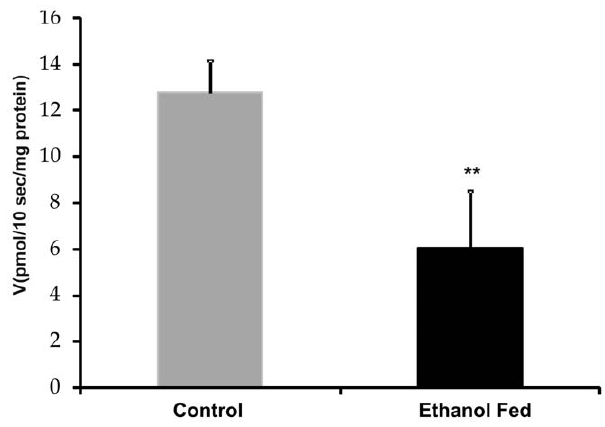
Figure 3. Uptake of 5-[ 14 C]-methylTHF (0.5 m M) was measured with and without analog (5 m M folic acid & 5 m M methotrex- ate)/inhibitor {5 mM thymine pyrophosphate (TPP) & 25 m M hemin} in incubation buffer of pH 5.0. Bars are mean 6 SD of 4 separate uptake determinations.